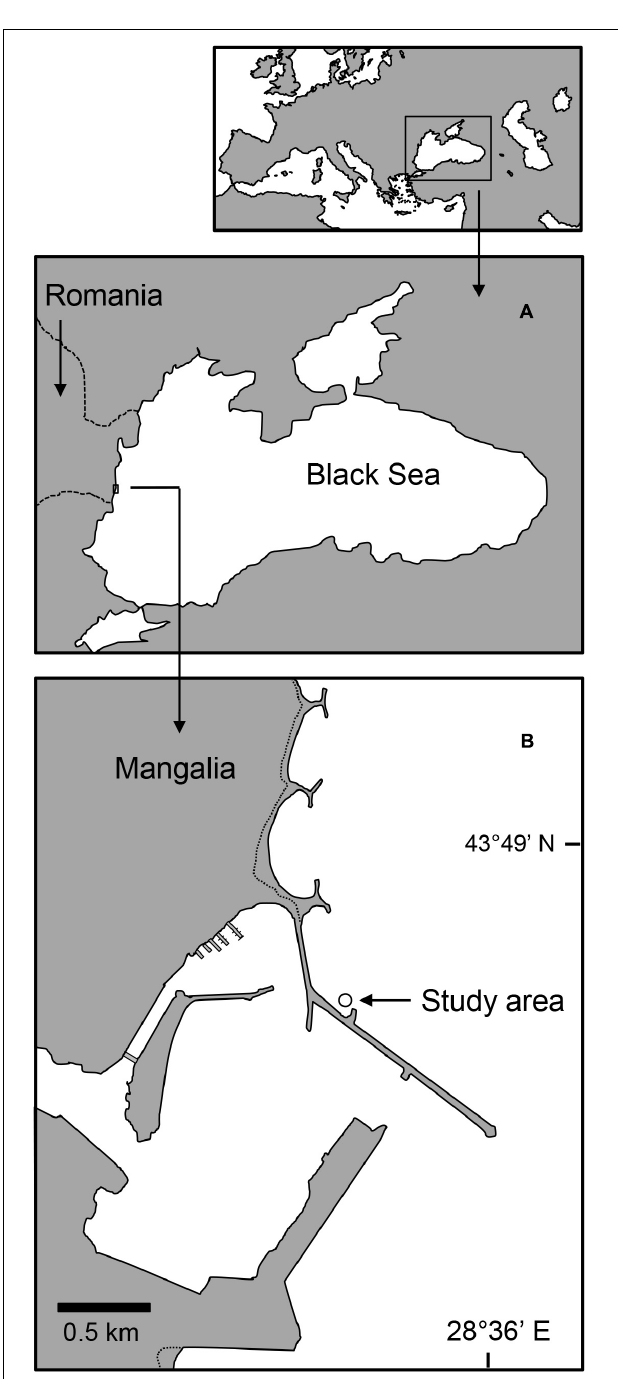
FIGURE 1 | Map outlining the Black Sea (A) and the approximate location of the study area (B) , immediately adjacent to the city of Mangalia, on the Romanian southern